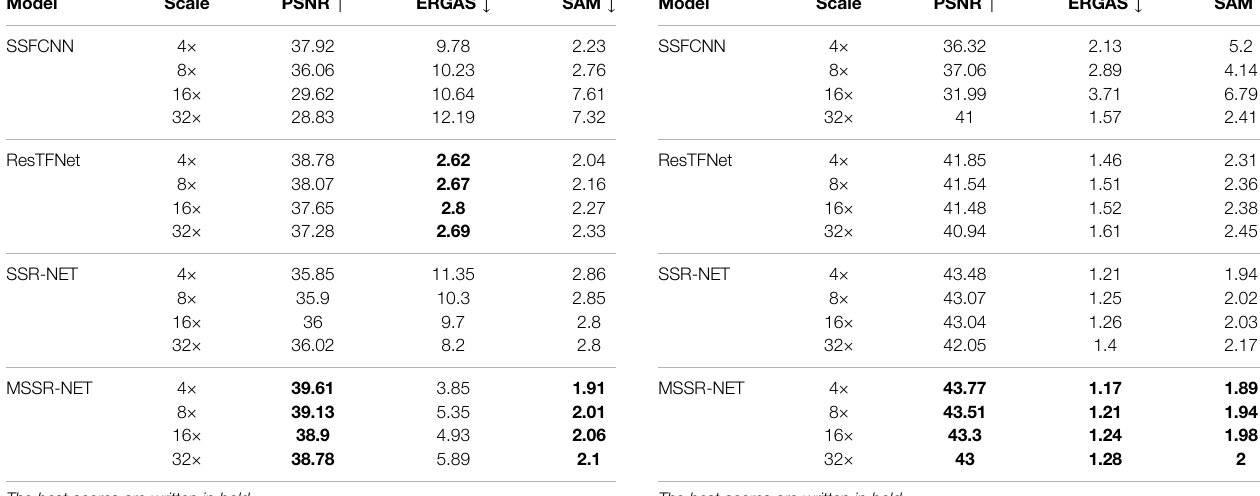
TABLE 2 | Quantitative results on Botswana dataset. HR MSI is generated according to Type 1 model. Model Scale